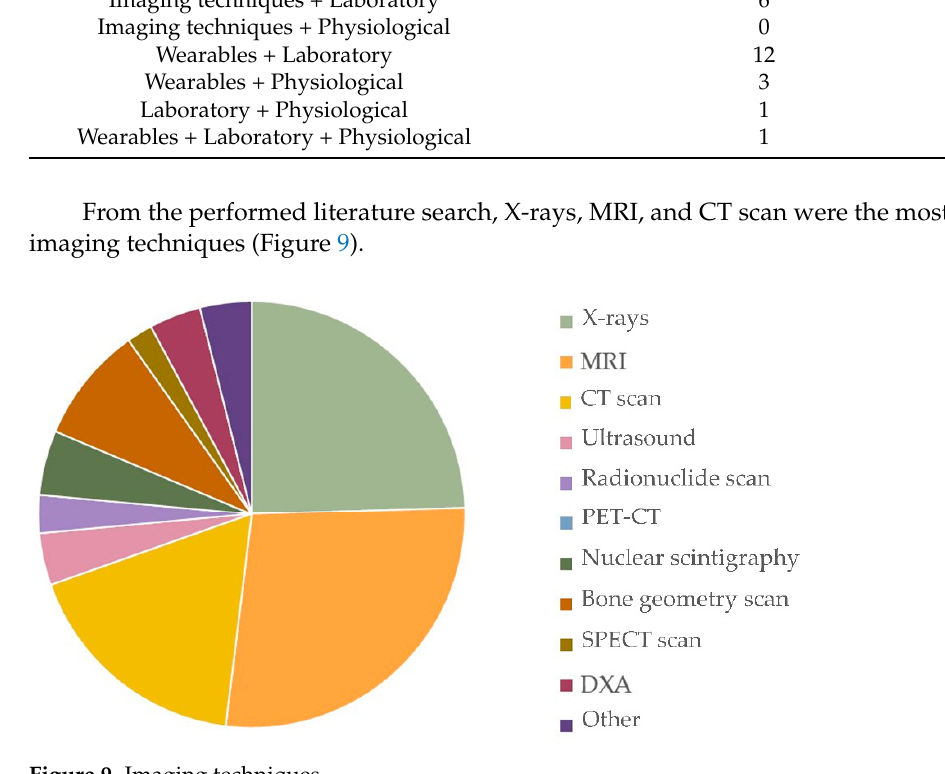
Table 1. Combined approaches of different technologies and number of articles in which they are reported.